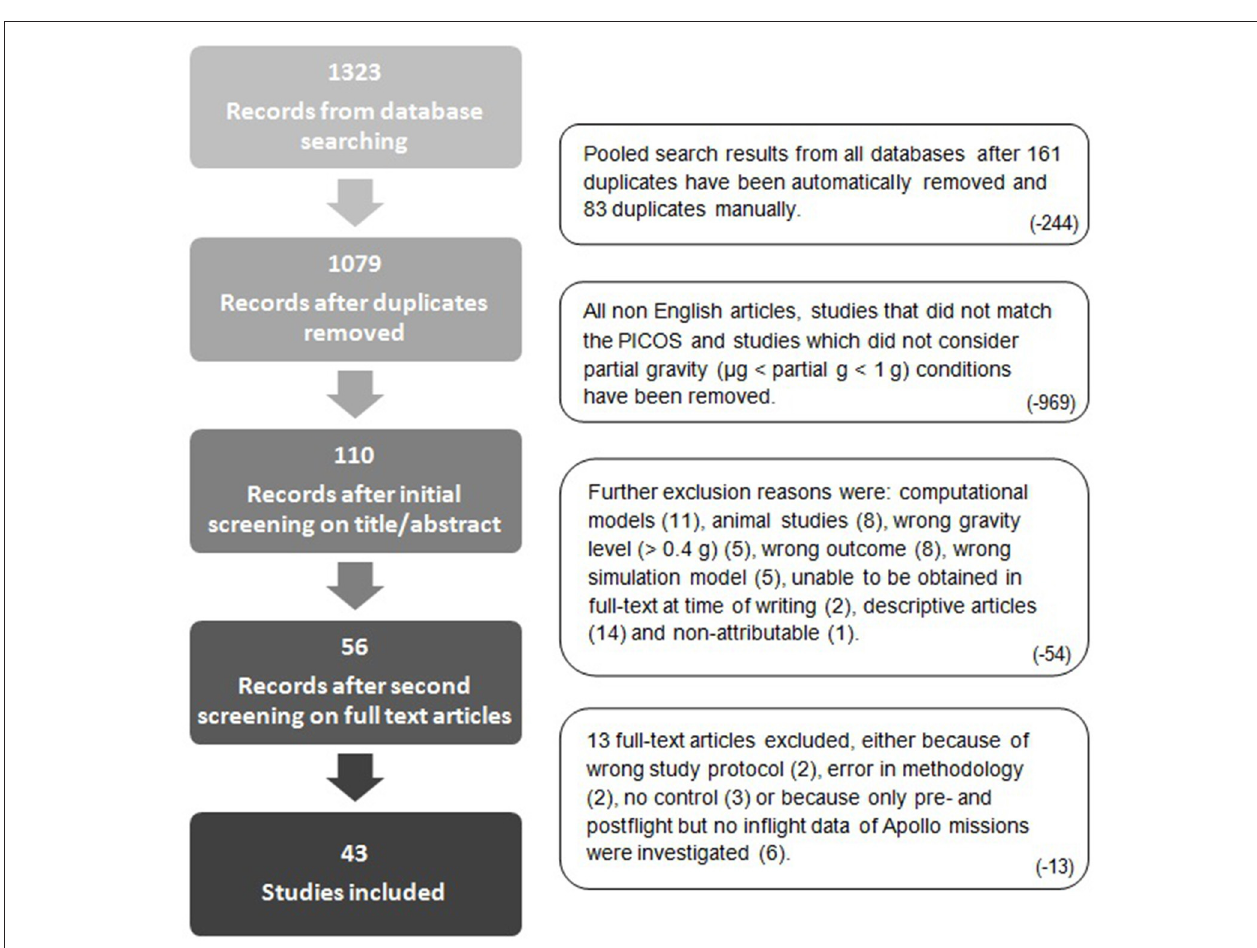
FIGURE 2 | Search and screening strategy and